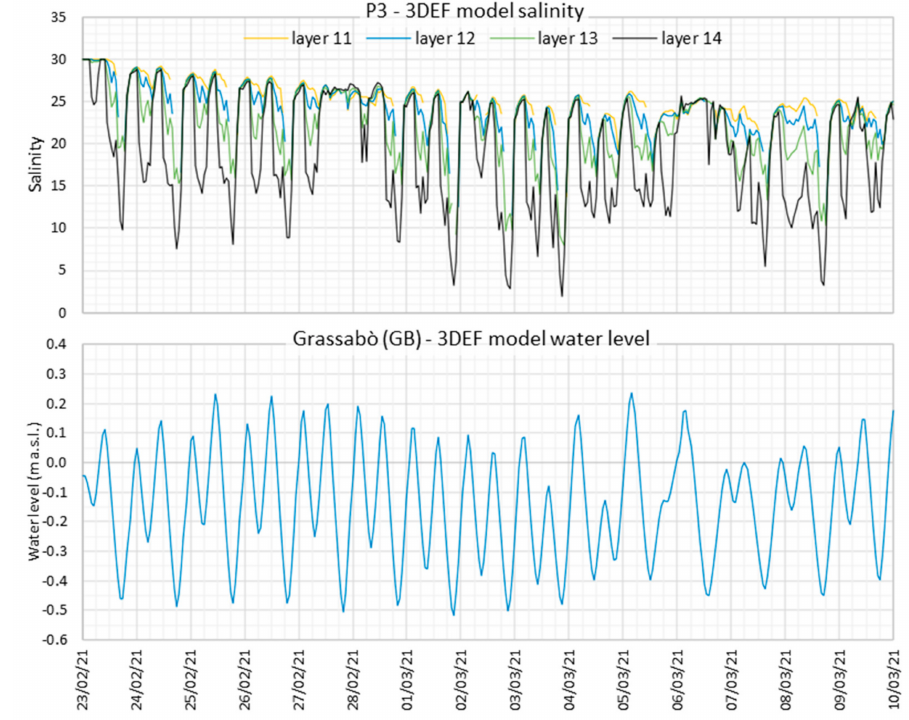
Figure 13. 23 February–9 March 2021 simulation. Salinity in the position of P1-P3 moored probes calculated by the model for the surface layers (11–14).